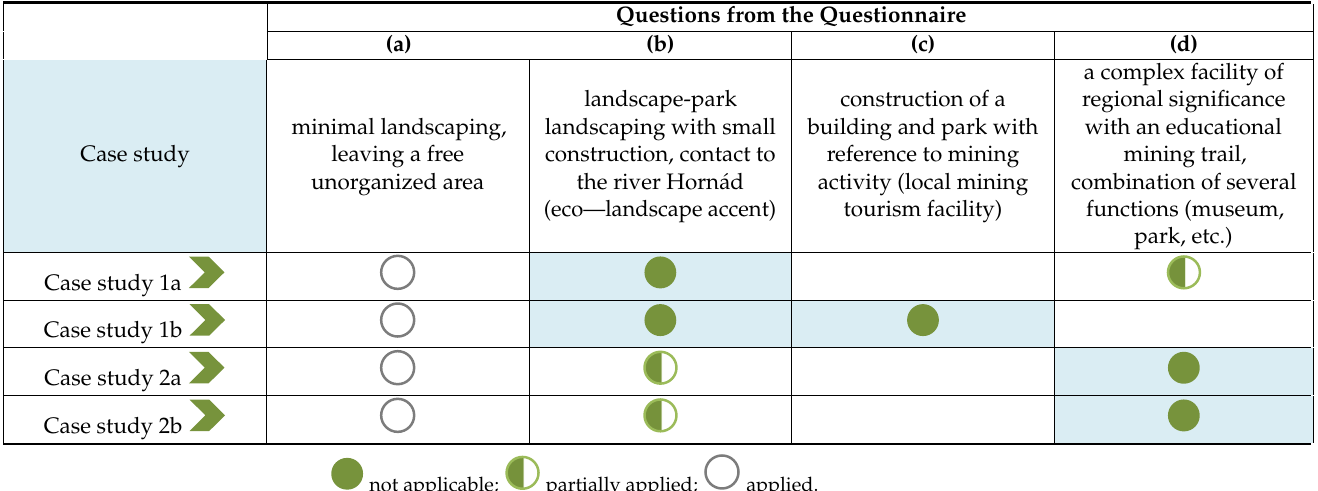
Table 2. Potentials of the location.